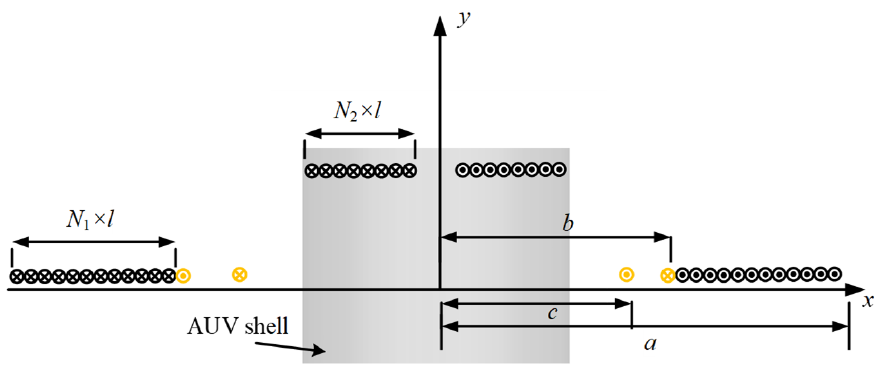
Figure 6. Cross-sectional view of the proposed magnetic coupler. Since AUV needs to maintain a radial offset of at least 30 mm; in other words, the inner diameter of the PI coil should be greater than 130 mm, assuming c = 130 mm. Figure 7 shows the magnetic induction intensity distribution on line l 1 varying with the size of the PI